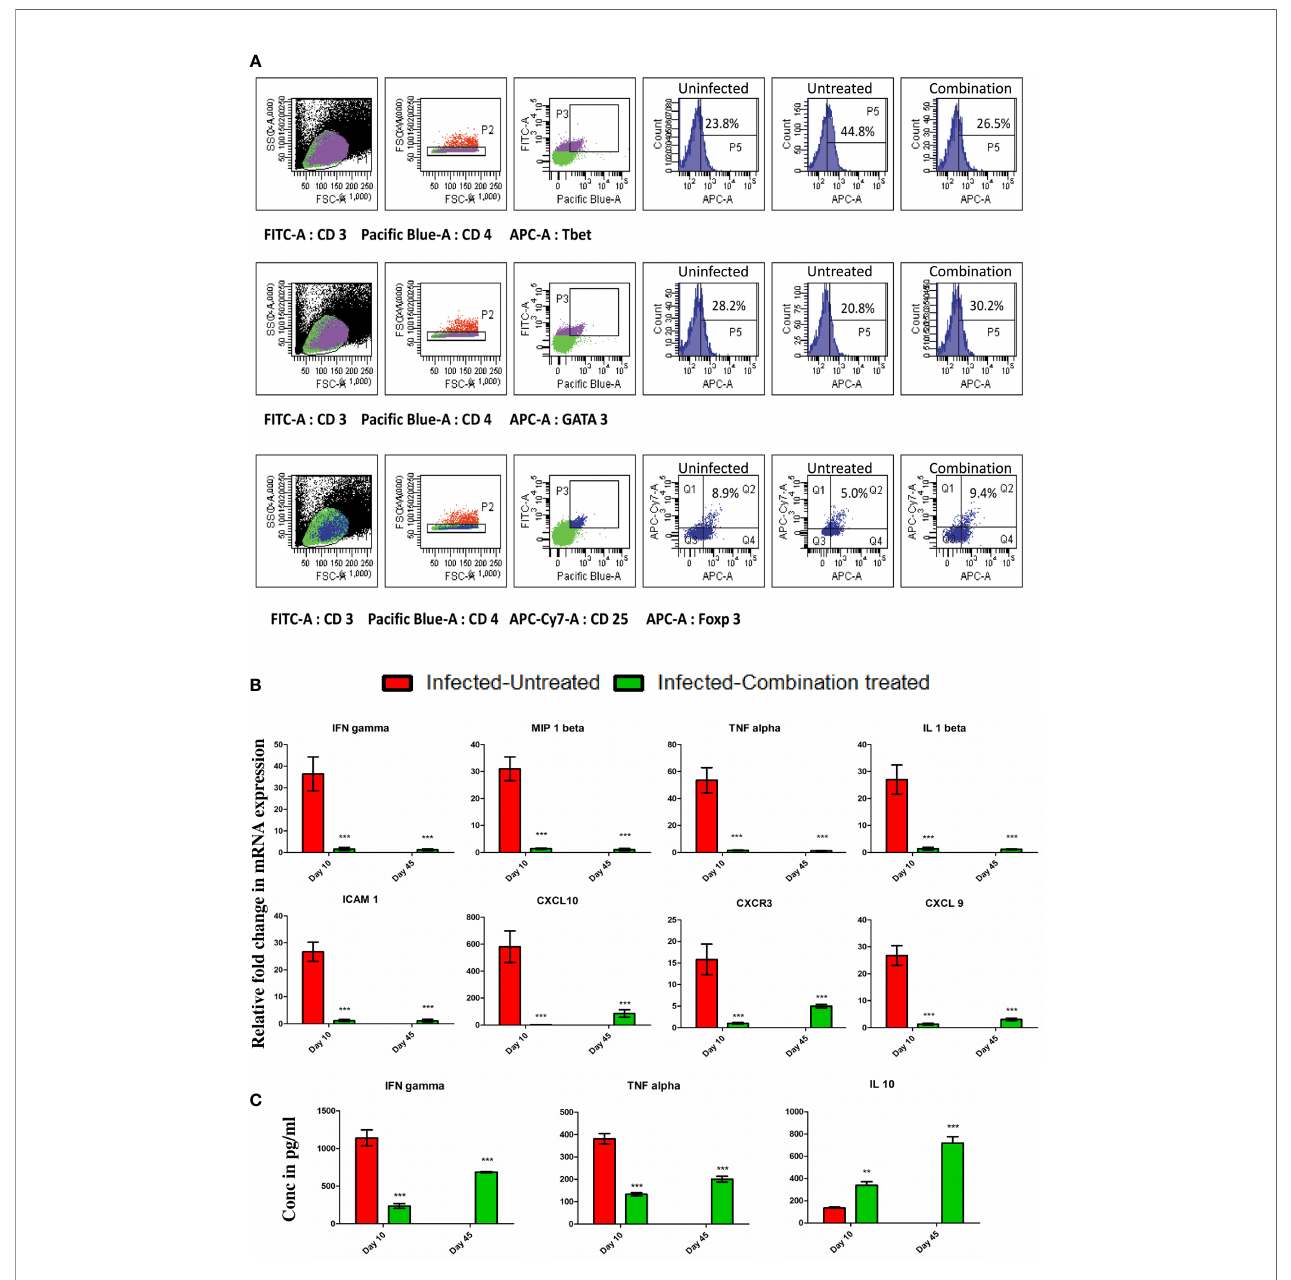
FIGURE 5 | (A) Splenocytes were isolated from the spleen of uninfected, infected-untreated, and infected-combination-treated groups on day 10 p.i. Surface staining was performed with anti-mouse CD3-FITC conjugated antibodies, anti-mouse CD4-PB conjugated antibodies and anti-mouse CD25-APC-Cy7 conjugated antibodies. Intracellular staining with anti-mouse Tbet-APC conjugated antibodies, or anti-mouse GATA3-APC conjugated antibodies or anti-mouse Foxp3- Alexa Fluor ® 647 conjugated antibodies was performed to determine the percentages of CD3+ CD4+ Tbet+ T cells, CD3+ CD4+ GATA3+ T cells and CD4+CD25+Foxp3+ T cells in spleen. (B) Gene expression of IFN gamma, MIP 1beta, TNF alpha, IL 1beta, ICAM 1, CXCL 10, CXCR3 and CXCL 9 in the brain of infected-untreated vs infected-combination treated group on day 10 and 45 p.i. Data is expressed as mean ± S.D of relative fold change in mRNA expression from 3 mice per group (C) Serum cytokine analysis of IFN gamma, TNF alpha and IL 10 levels of infected-untreated vs infected-combination treated group on day 10 and 45 p.i. Data is expressed as mean ± S.D of serum cytokine concentrations from 3 mice per group. [* P <0.05, ** P <0.01, *** P <0.001, n.s., not signi fi